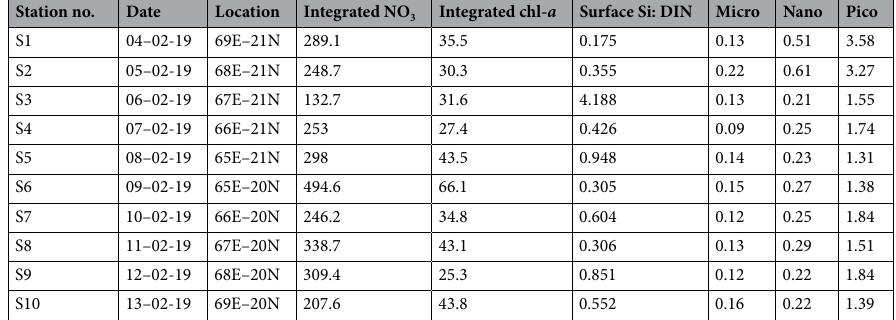
Table 1. Station-wise distribution of integrated nitrate (NO 3 ) concentration (mmol/m 2 ), integrated chlorophyll- a (chl- a ) concentration (mg/m 2 ), surface silicate/dissolved inorganic nitrogen (Si/DIN) ratio, micro, nano and picophytoplankton biomass concentrations